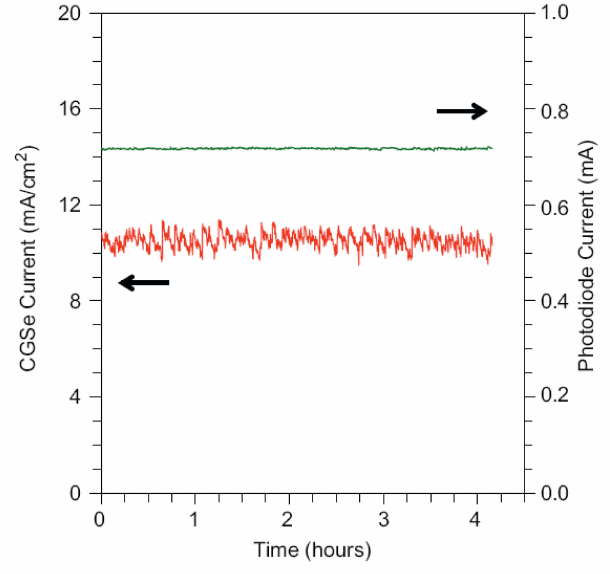
Figure 10. Four-hour test under simulated AM 1.5G light at − 0.9 V vs. SCE for CuGaSe 2 photocath- ode. Photodiode current shows constant light intensity. Reproduced with permission from [151]. Copyright Elsevier B.V.,